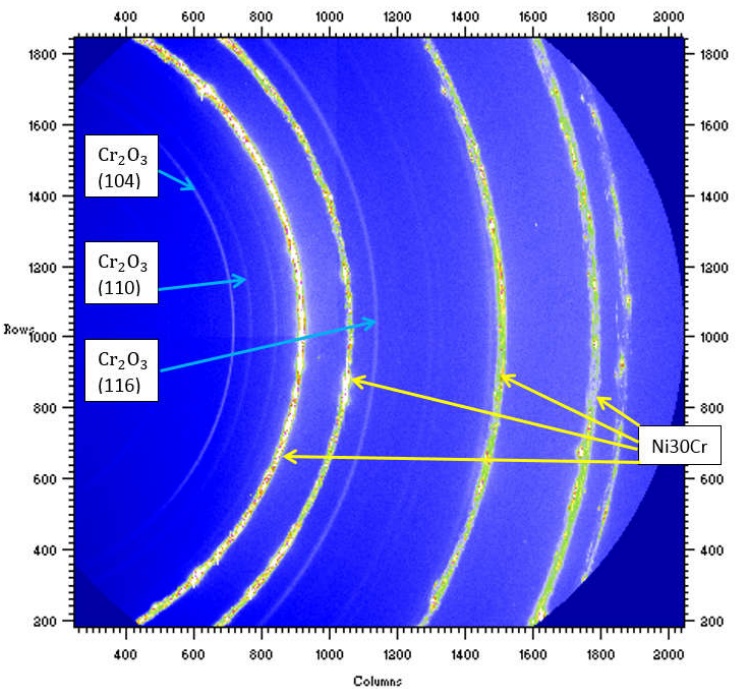
Figure 5. Diffracted rings for the Ni30Cr/Cr 2 O 3 system.